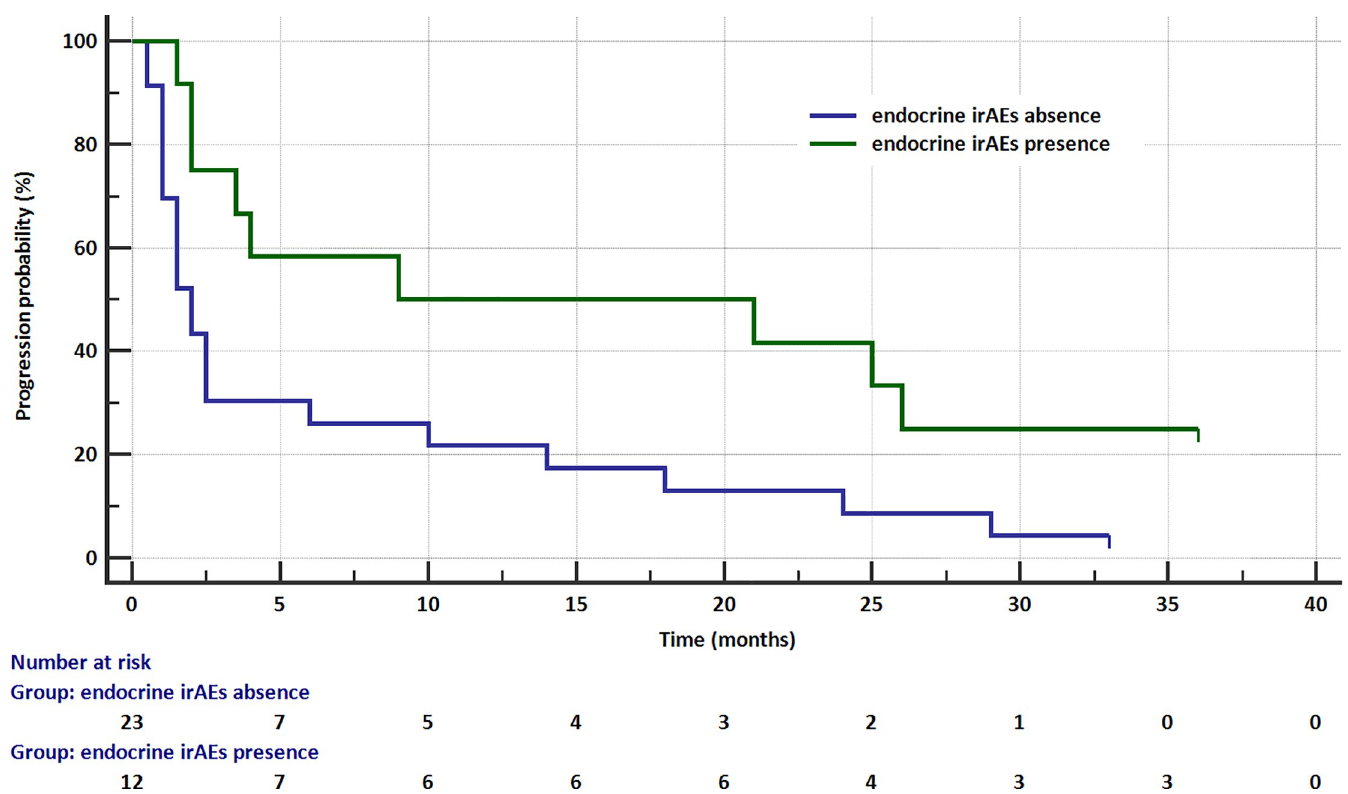
Fig 2. Kaplan–Meier PFS curve in patients with and without endocrine